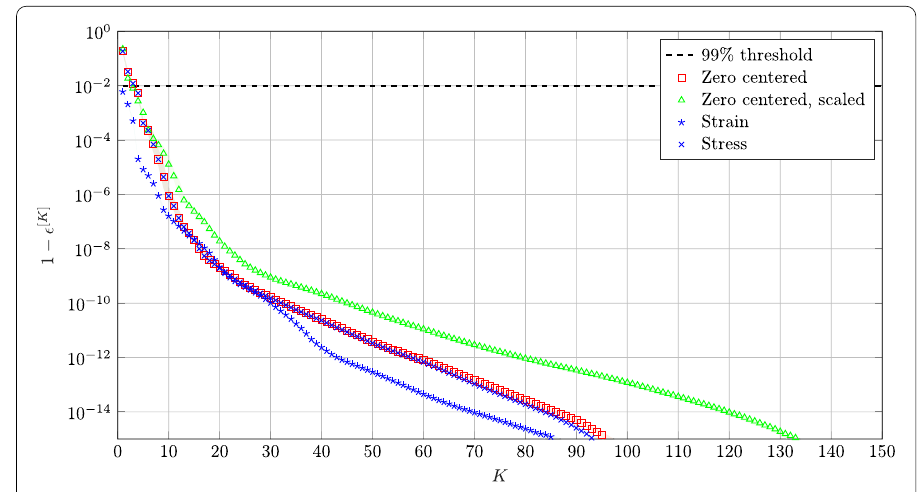
Fig. 4 Mean ratio of eigenvalues with 99% threshold over all training sets of the pure bending problem. The shaded area represents the range over all training sets